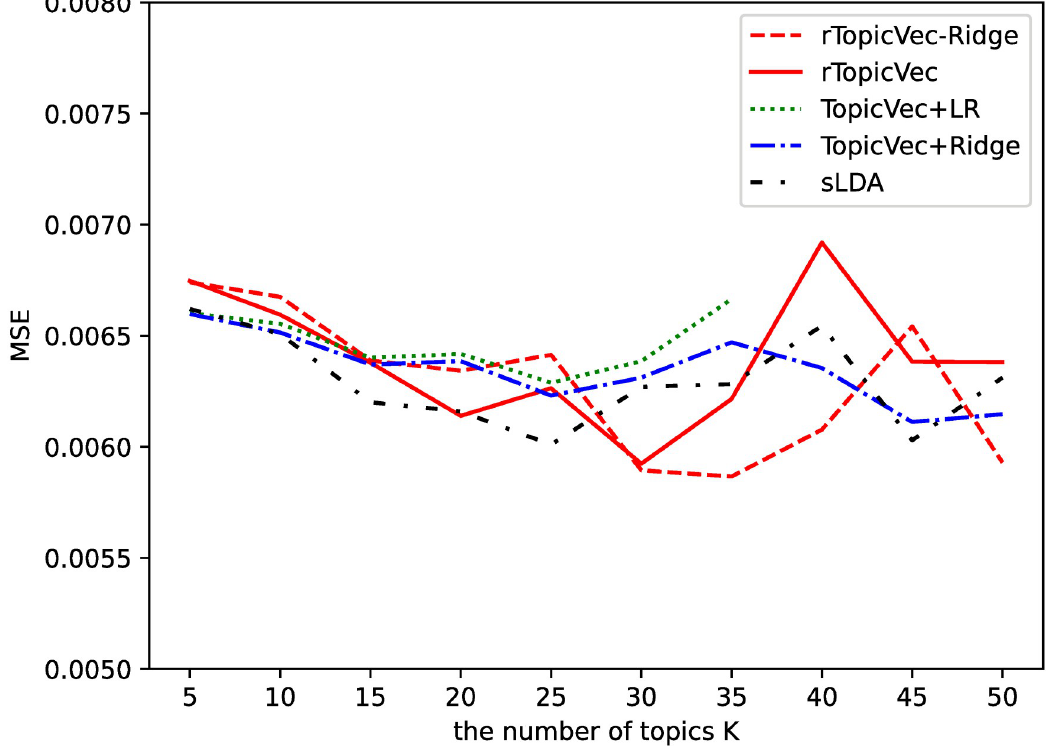
Fig 3. Average MSE for varying number of topics K on validation sets of stock return rates